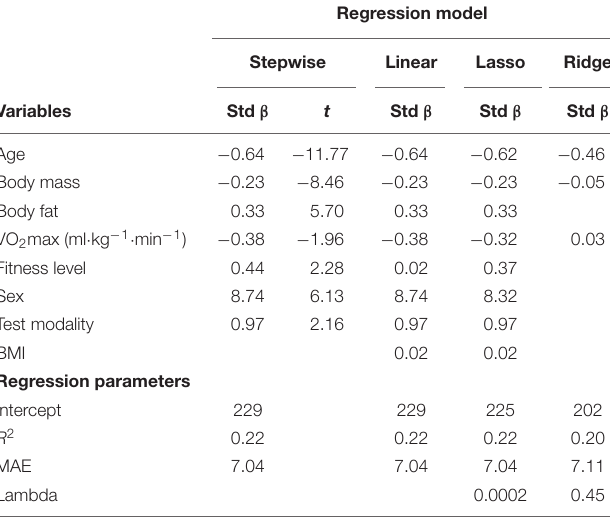
TABLE 2 | Multiple regression